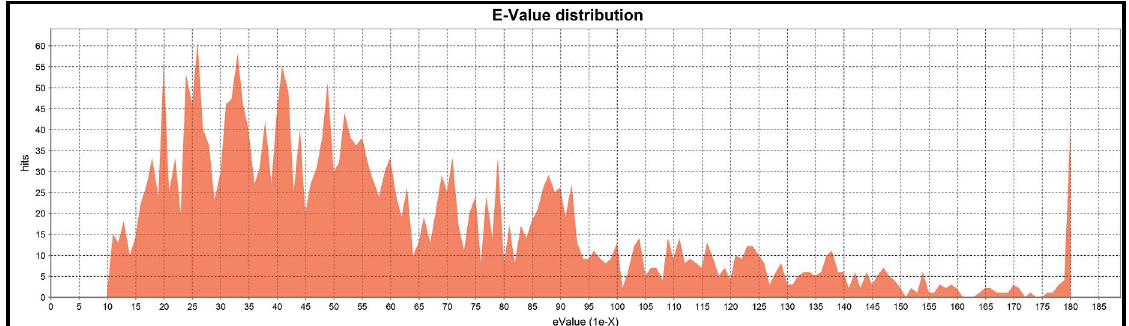
Figure S3 : Average e-value distribution of the best 20 hits of the 140 EST-Contigs submitted to BlastX by